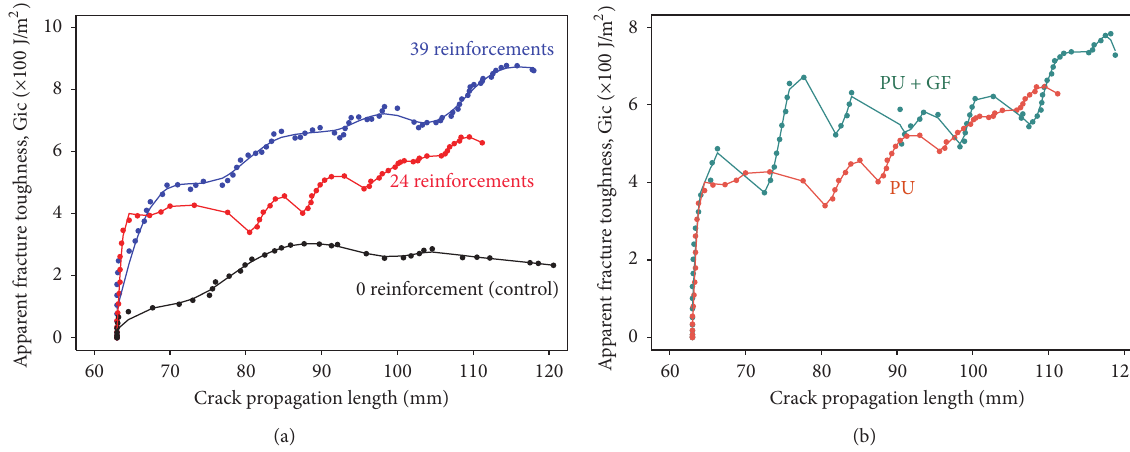
Figure 8: Mode I crack growth resistance curves (R-curves) of (a) polyurethane (PU) adhesive with different levels of through-reinforcement; and (b) different adhesive types (PU or PU + GF) with the same level of through-reinforcement